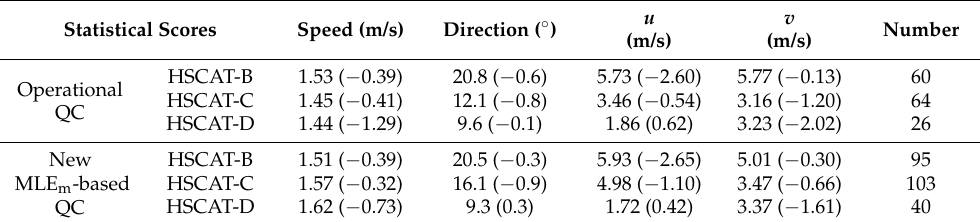
Table 6. The quality of QC-accepted of high winds ( w > 20 m/s) w.r.t. buoy winds. Statistical Scores